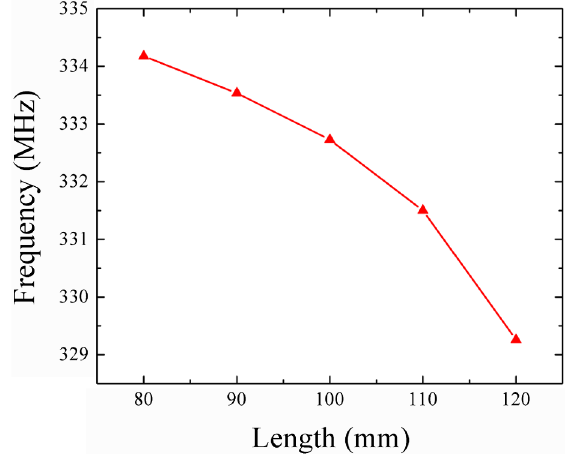
FIG. 17. The influence of the last half drift tube length on the resonance frequency for a fixed outer tank radius.